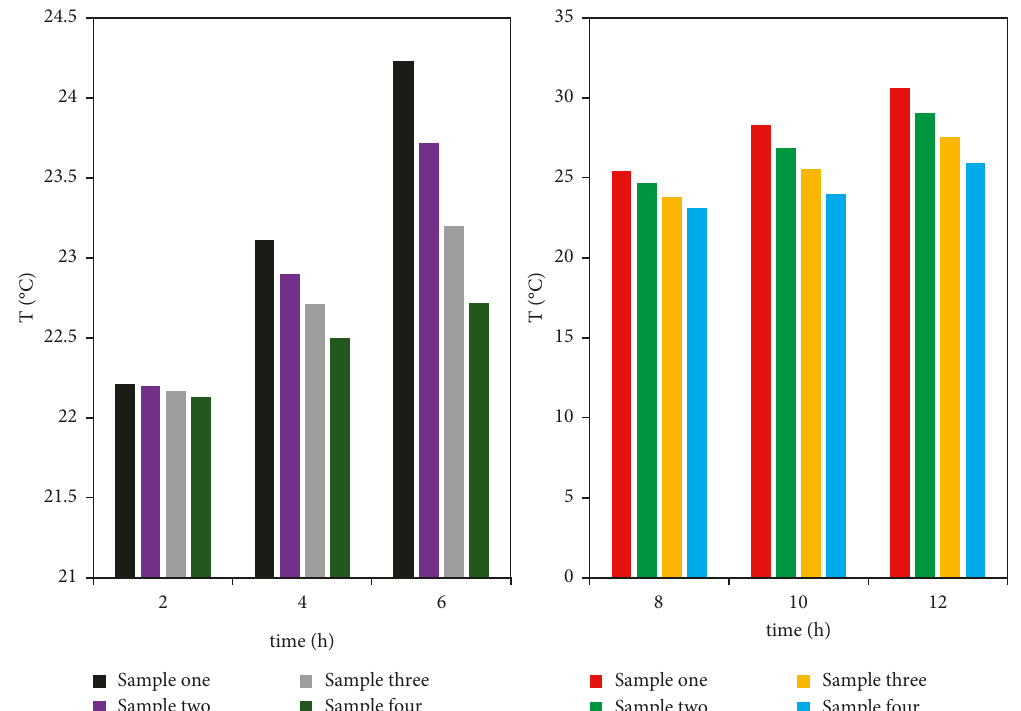
Figure 6: The temperature change diagram of the low temperature side when the east wall samples with different ratios absorb heat.